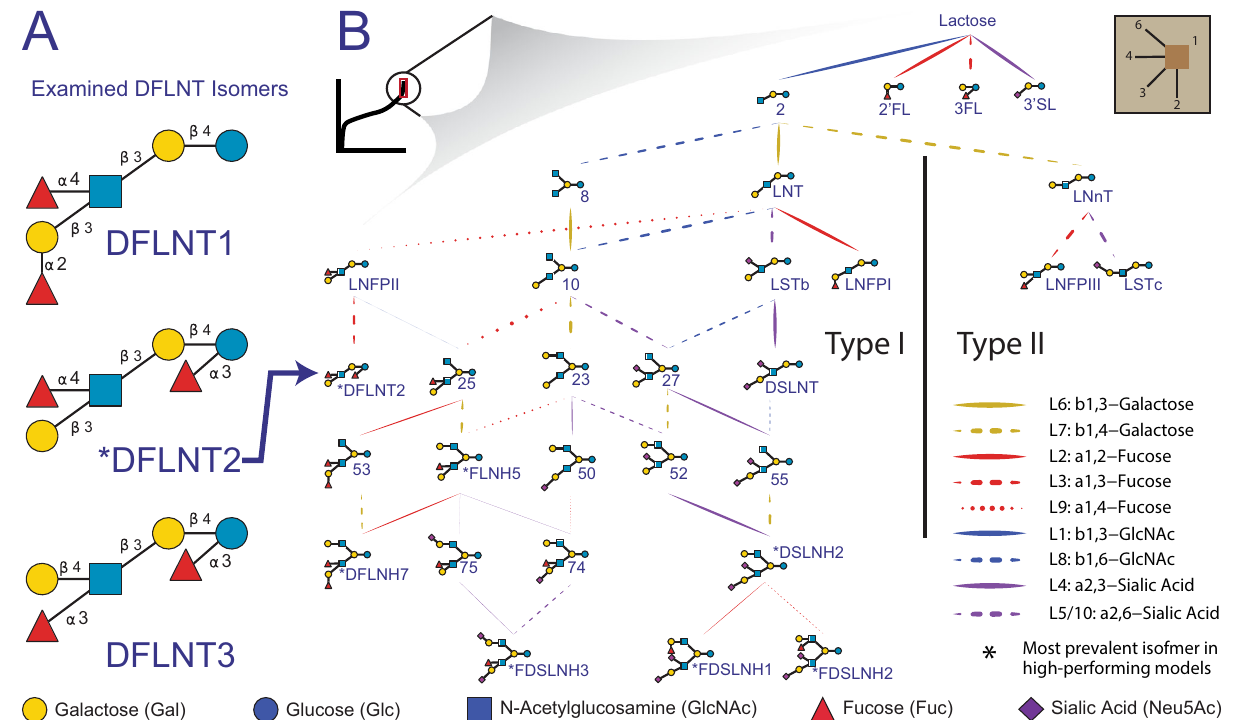
Fig. 4 Summary network of the most important reactions in the Reduced Network. Observed, intermediate and candidate HMOs most important to commonly high-performing networks were selected from the Reduced Network (Fig. 3D; Supplementary Methods 4.2). A Several ambiguous isomers (Supplementary Fig. 5) were preferred (Supplementary Fig. 14) in the commonly high-performing models. B A summary network was constructed from reaction importance; an aggregation of the proportion of high-performing models that include a reaction, and the enrichment of a reaction in the high- performing model set (see Methods section). Line weight indicates the relative importance of each reaction. Line color corresponds to the monosaccharide added at each step and line type corresponds to the linkage type. The summary network naturally segregates into type-I and type-II backbone structures. For measured HMO de fi nitions (e.g., FDSLNH and DSLNT) see Methods section, for intermediate HMO de fi nitions (e.g., 8, 10, or 25) see Supplementary Dataset 3, for uncertain structures (e.g. DFLNH7, FLNH5) see Supplementary Fig.